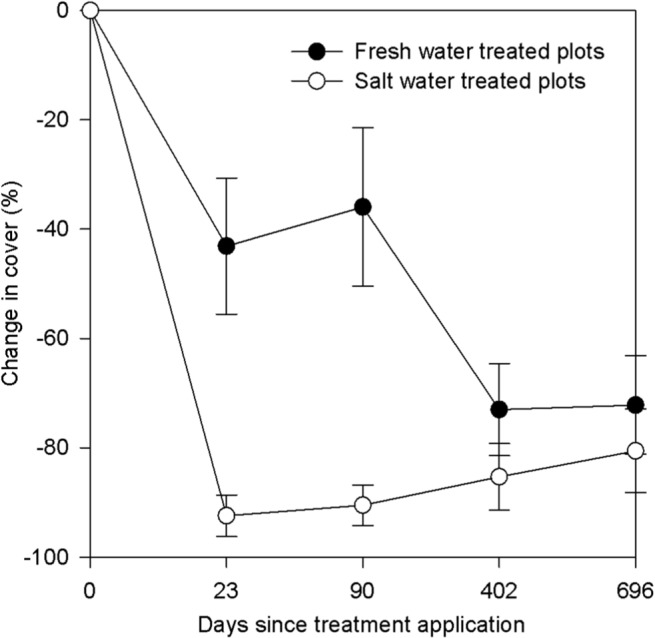
Effects of storm surge treatments on Sarracenia rosea over time.Line graph comparing Sarracenia rosea percent cover change across storm surge water treatments over time.